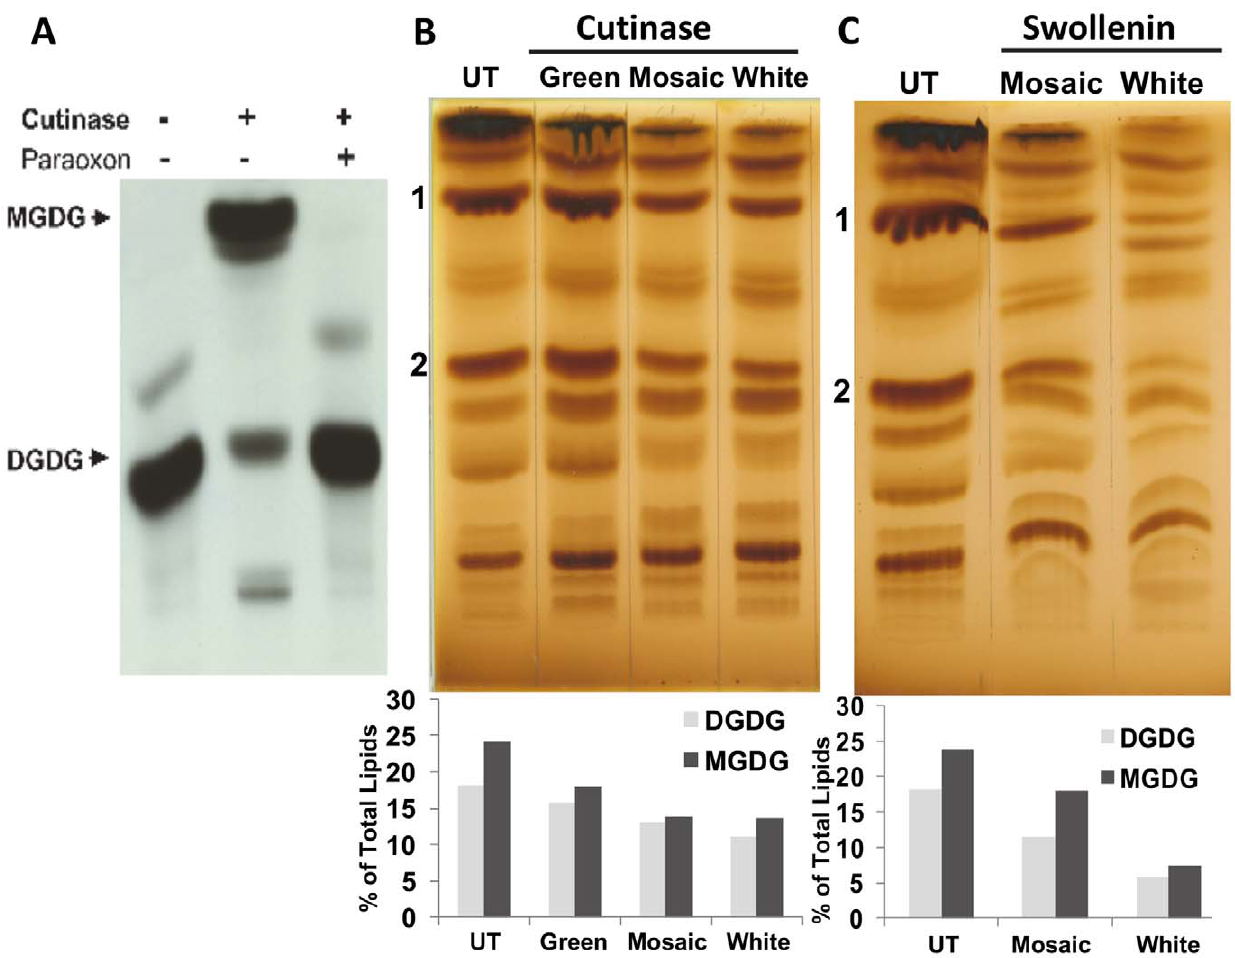
Figure 7. Autoradiogram and TLC showing lipid hydrolysis. A, Autoradiogram of TLC plate showing hydrolysis of the lipid DGDG by F. solani pisi cutinase is inhibited by active serine-directed inhibitor paraoxon. The 14 C-DGDG was incubated with purified cutinase for 2 h at 37 u C in the absence and presence of paraoxon (active serine-directed inhibitor). All reactions were extracted and resolved by silica-TLC. Positions of MGDG and DGDG corresponding to the migration of authentic unlabeled standards are shown. B, TLC of green, mosaic and white leaves from cutinase expressing transplastomic tobacco lines and percentage of MGDG and DGDG in total extracted lipids. C, TLC of mosaic and white leaves from swollenin expressing transplastomic tobacco lines and percentage of MGDG and DGDG in total extracted lipids. UT: leaf lipid extracted from untransformed plant. 1: MGDG. 2: DGDG. Lipid bands were visualized using iodine vapor and IDV values were calculated by densitometry.